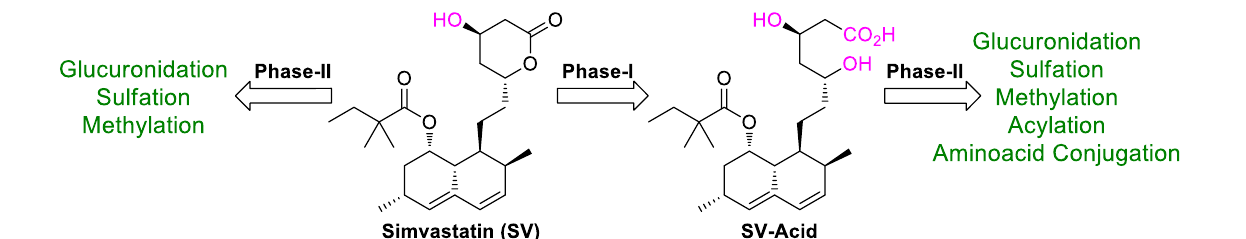
Figure S22: Possible structures of M21 – M23 ; Figure S23: Mass Spectra of M24 – M26 in Ion Trap/QqQ; Figure S24: Possible structures of M24 – M26 ; Figure S25: Mass Spectra of M27 – M28 in Ion Trap/QqQ; Figure S26: Possible structures of M27 – M28 ; Figure S27: Mass Spectra of M29 in Ion Trap; Figure S28: Table S1: Concentration of Protein (Calibration curve of BSA); Table S2: RLMs Incubations; Table MS2 spectra of M29 ; Table S1: Concentration of Protein (Calibration curve of BSA); Table S2: